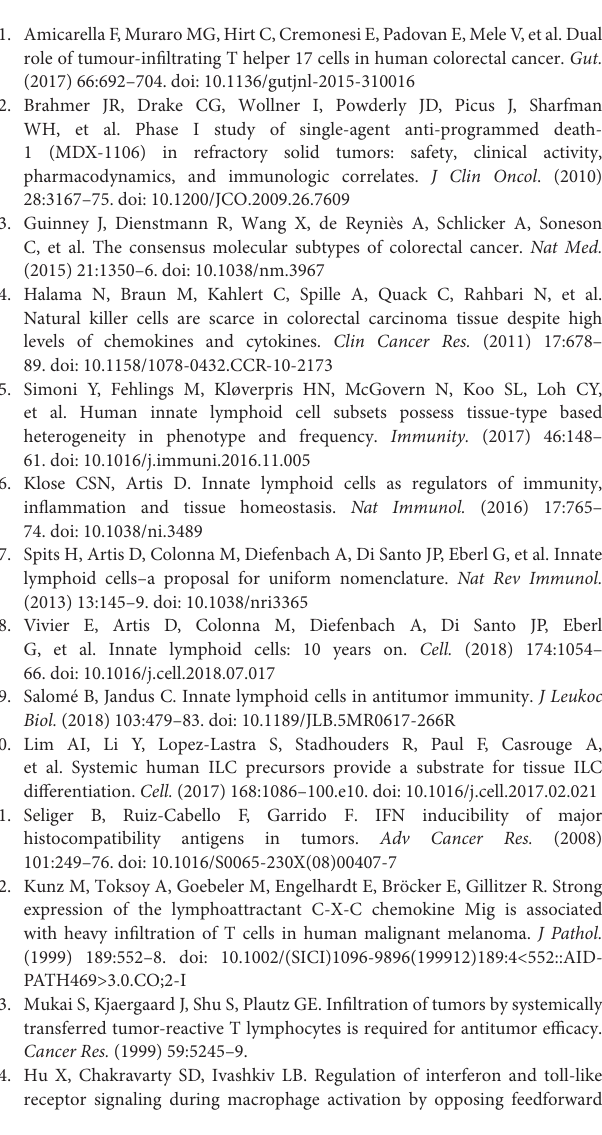
Representative example of the staining on PBMCs of a healthy donor. Gray histograms correspond to the FMO. Figure S2 | Distribution of ILC2 c-Kit − and c-Kit + in healthy donors and metastatic colorectal cancer patients. Percentage of ILC2 c-Kit − and c-Kit + for HD and metastatic colorectal cancer patients at baseline and after treatment (TT). Columns, the means of ILC2 for each patient; bars, SEM. ∗∗∗∗ p < 0.0001, NS (non-significant) as determined by Student’s t -test. Figure S3 | Progression-Free Survival Kaplan-Meier curves of chemotherapy-naïve metastatic colorectal cancer patients. Patients ( n = 73) stratified by the frequency of total ILCs distributed into low + medium ( n = 50) vs. high ( n = 23) terciles. Table S1 | Clinicobiological characteristics of CRC patients. The table summarizes the clinicobiological characteristics of CRC patients enrolled in